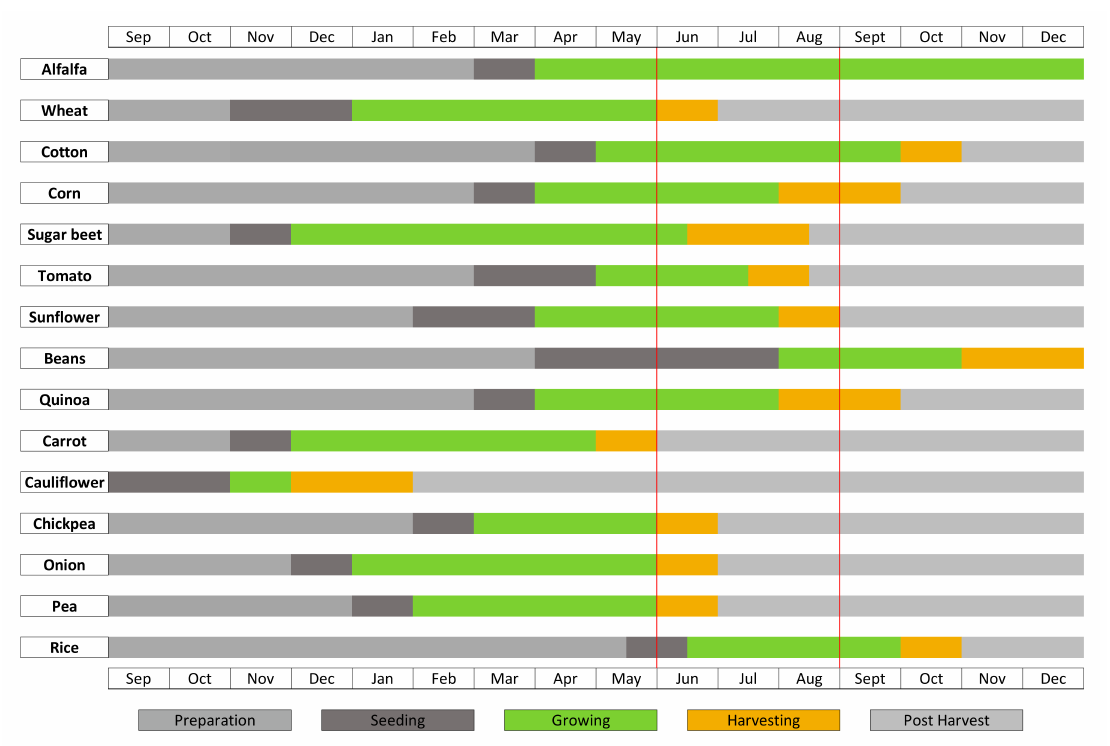
Figure 2. Crop calendar in 2015. The two red vertical lines denote the starting and final dates of the available TanDEM-X